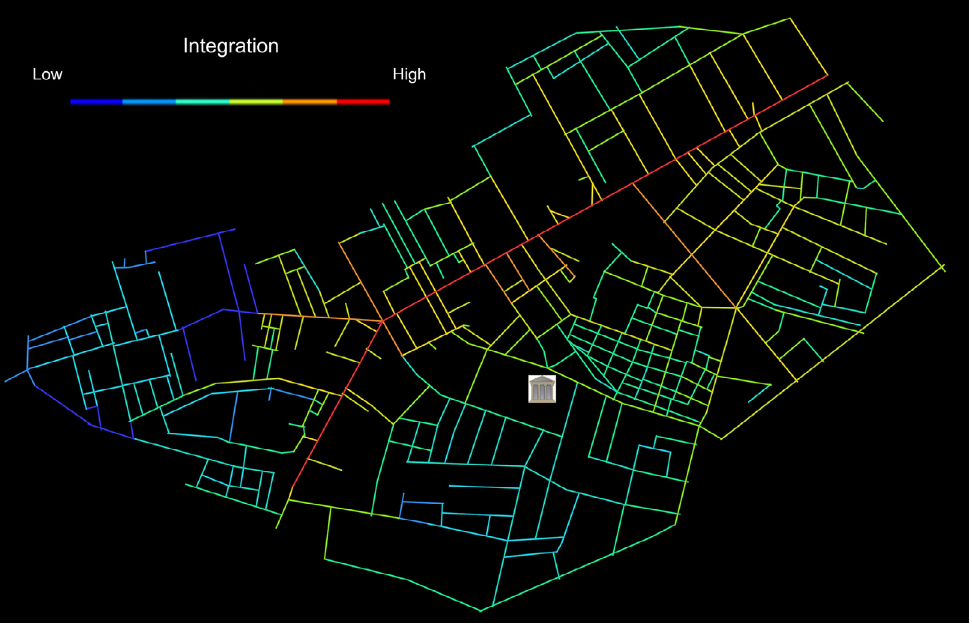
Figure 2. The Campo della Magna Mater on an axial graph, which shows the calculation of integration (radius 3, 385 street seg- ments). Streets with the highest integration value are shown in red. Streets with the lowest integration value are shown in dark